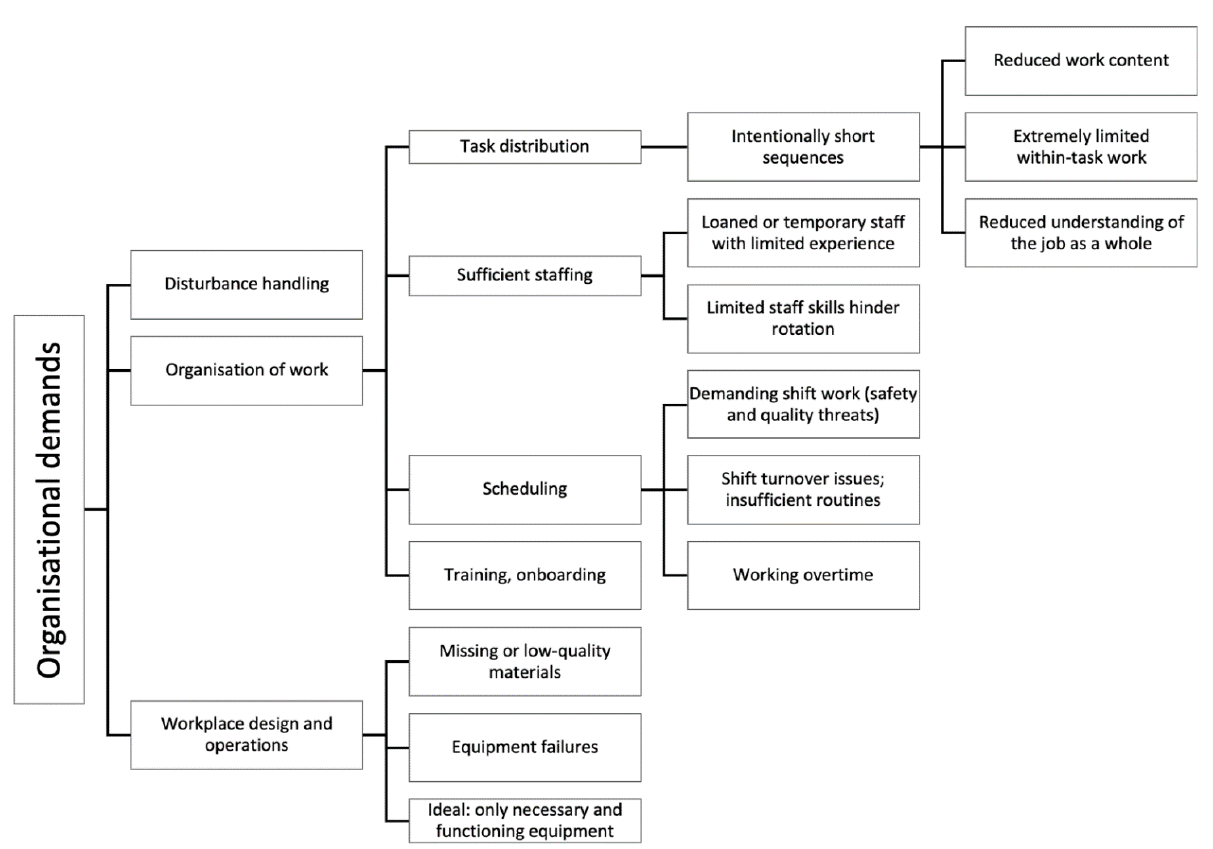
Figure 4. Organisational demands.